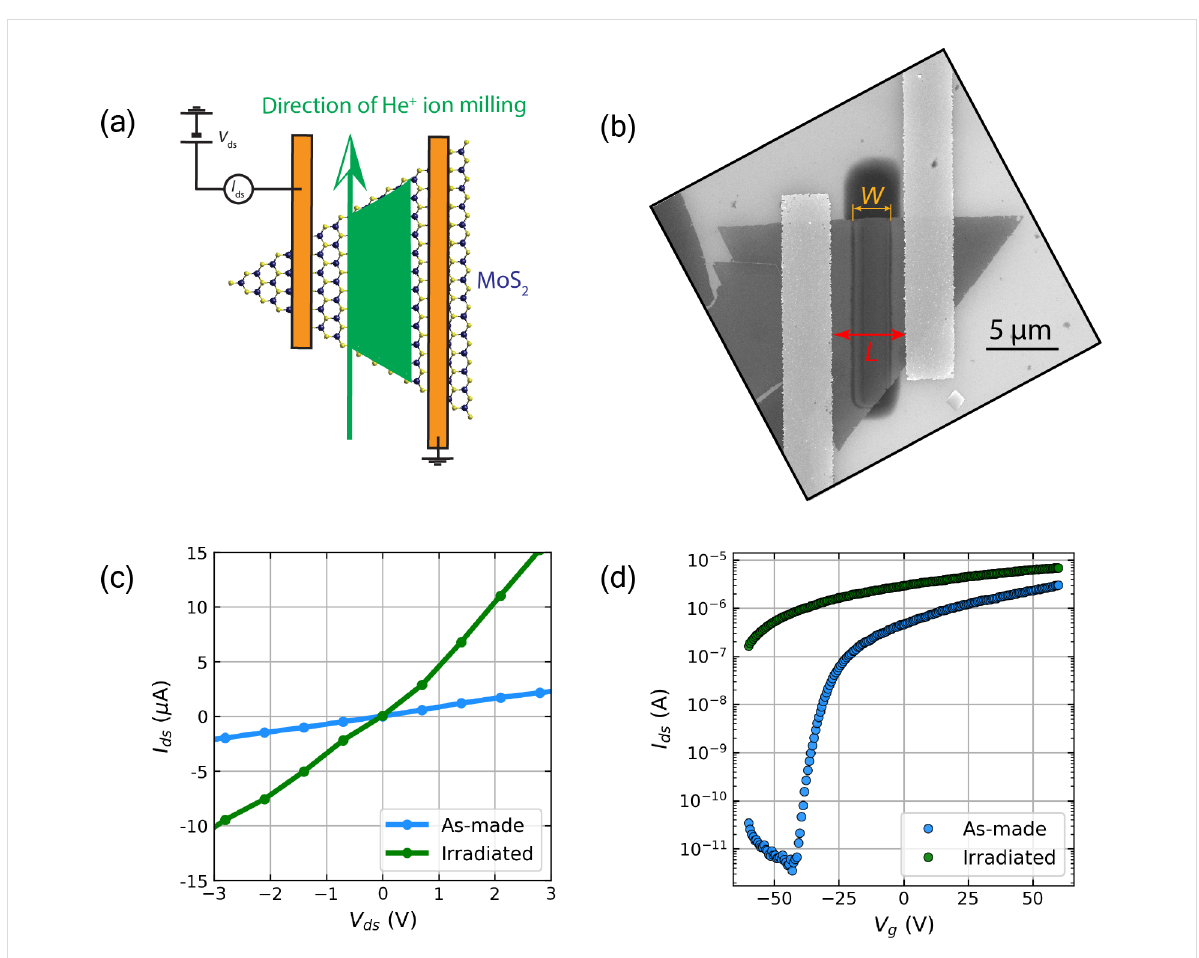
Figure 1: Experimental design and basic electrical characteristics. (a) Sketch demonstrating the irradiation strategy on contacted CVD-grown mono- layer MoS 2 devices. The green area marks the designed irradiation area. (b) SEM image of an irradiated device. W marks the width of the exposed region, while L is the length of the FET channel. L is 5 μ m in the image. (c) I – V curve of a device after irradiation (corresponding to I R = 7%). (d) Transfer curve of the same device demonstrating reduced gate tunability and a higher electrical conductance after He + ion